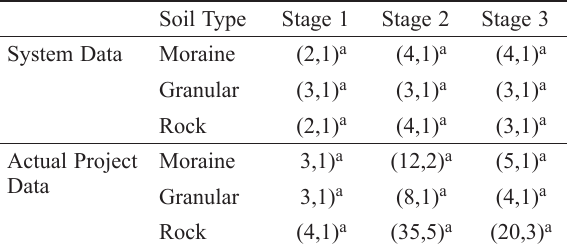
Table 2. Comparison of system fleet results with actual project